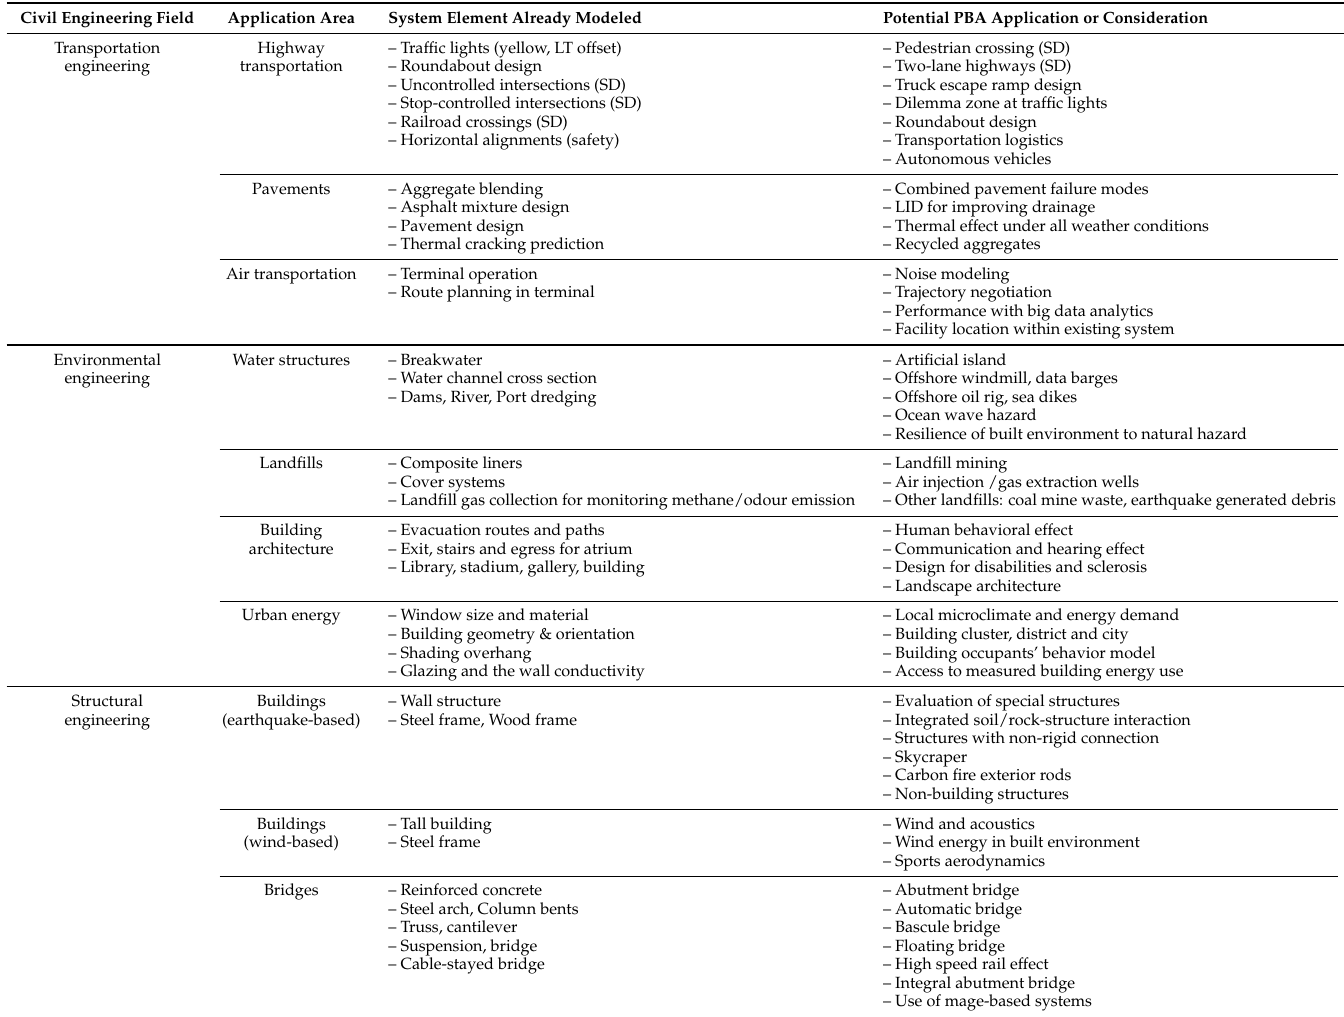
Table 3. Potential applications of